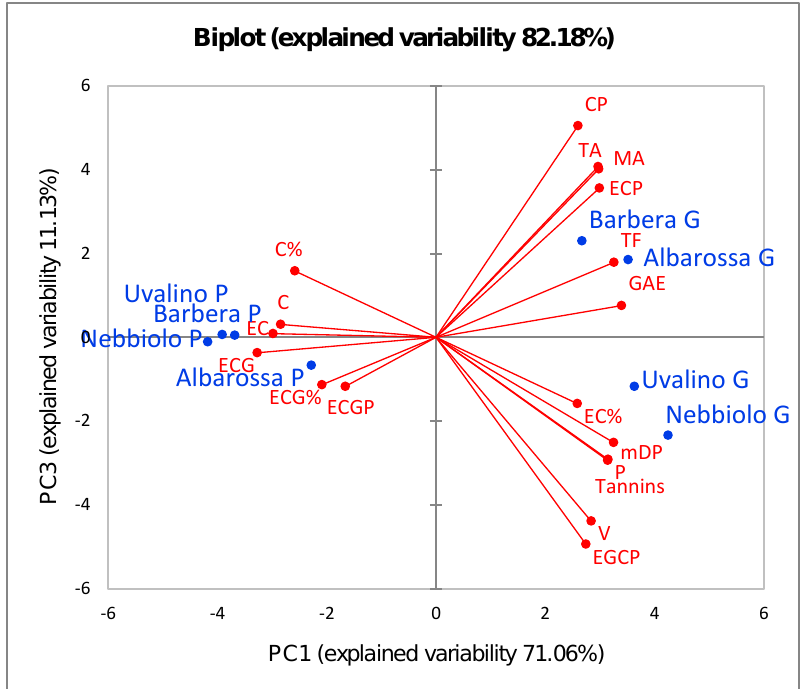
Figure 2. Representation of the loadings (variables) and the scores (skin extracts) in the plane defined by the 1st and 3rd Principal Components (PCA). For each cultivar (blue), the suffix G represents grape extracts, P represents pomace extracts. In red are reported the chemical variables that describe the polyphenolic profile of the extracts: GAE = total polyphenols; TF = total flavonoids; TA = total anthocyanins; MA = monomer anthocyanins; V = flavans reactive with vanillin; P = proanthocyanidins; Tannins = condensed tannins (phloroglucinolysis); mDP = mean degree of polymerization; C, EC, ECG = ( + )-catechin, ( − )-epicatechin and ( − )-epicatechin-3- O -gallate present as terminal units; CP, ECP, ECGP = ( + )-catechin, ( − )-epicatechin and ( − )-epicatechin-3- O -gallate present as extension units; EGCP = ( − )-epigallocatechin present only as extension unit; C%, EC%, ECG% = total percentages of the monomers (terminal + extension).